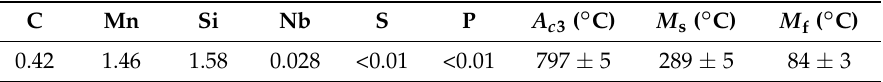
Table 1. Chemical compositions (wt%) and the temperature of A c 3 and M s